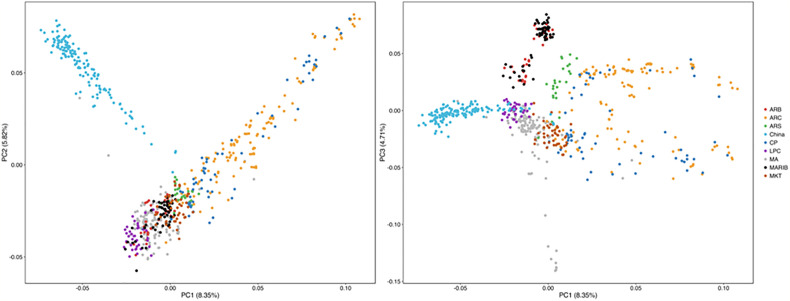
Parasites from Southern China were clustered with and separated from parasites from Southeast Asia by PCA. ARB/MARIB: Bangladesh; ARC/CP: Western Cambodia; ARS: Northwest Thailand; LPC = Laos; MA: Vietnam; MKT: Southern Myanmar.